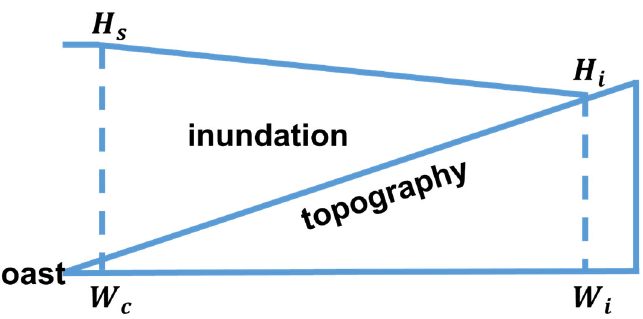
Figure 3. Illustration of calculation of inundation area using storm surge height and topography.